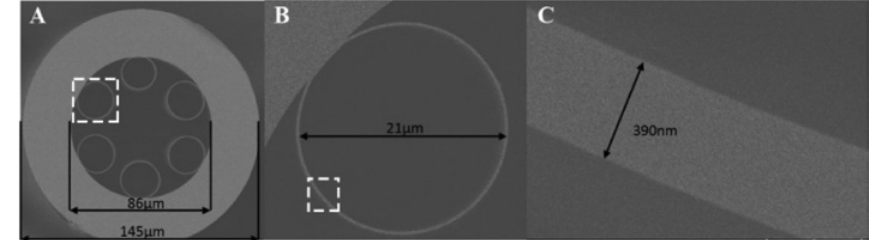
Figure 1: Scanning electron microscopy images of the (A) cross section of the HC-NCF, (B) circular side-capillary tube, and (C) tube wall. Images in (B) and (C) are enlargements of the regions indicated in (A) and (B),